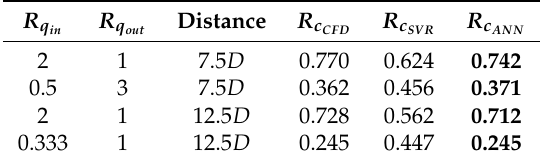
Table 11. SVR and ANN model comparison for 7.5D and 12.5D (better prediction values are made